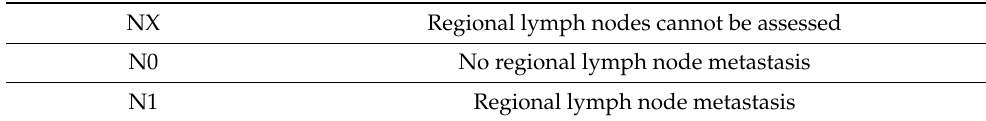
Table 2. Regional Lymph Nodes classification from TNM (8th Edition) classification system for cervical cancer.